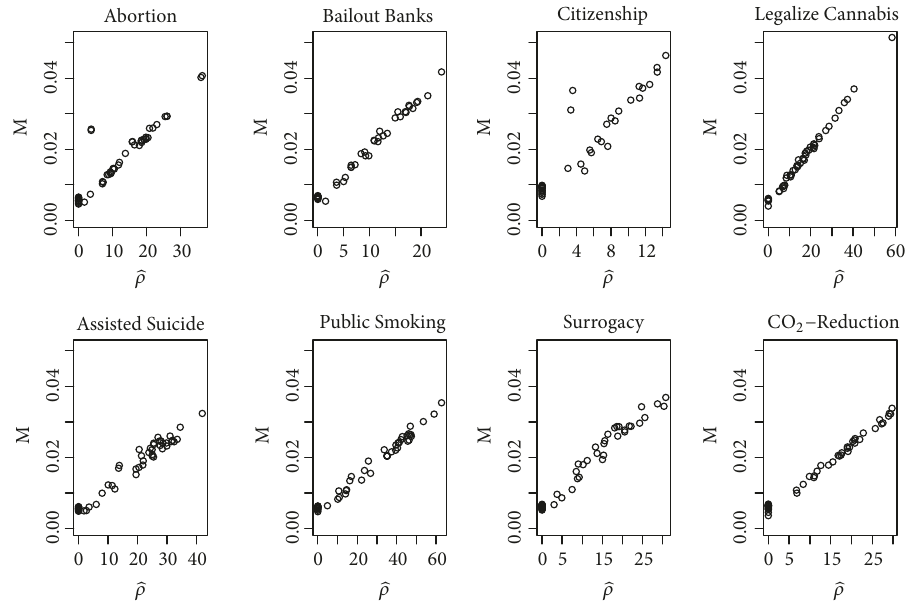
Figure 12: Mediation centrality 𝑀 of an individual (y-axes) plotted as a function of mediation representativeness ̂𝜌 of that individual, separately for each policy